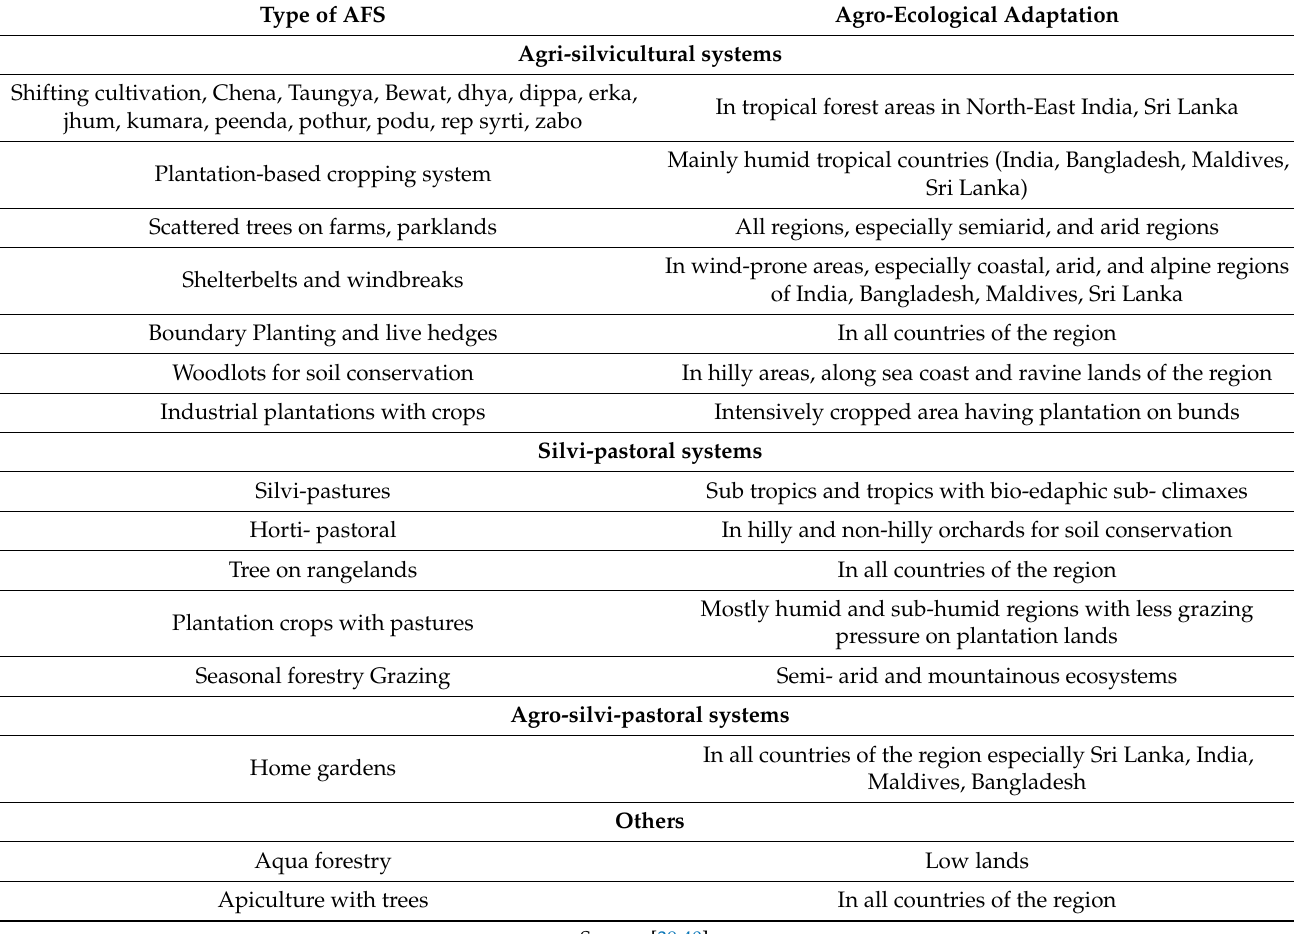
Table 2. Traditional agroforestry systems accepted/adopted in South Asia.